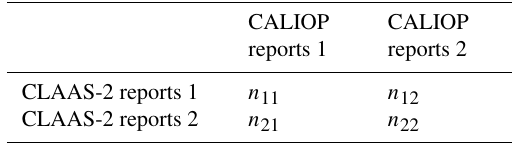
Table 2. Contingency table for the CLAAS-2 and CALIOP obser- vations; n is the number of cases and 1 and 2 correspond to clear or cloudy for the cloud mask and water or ice for the cloud